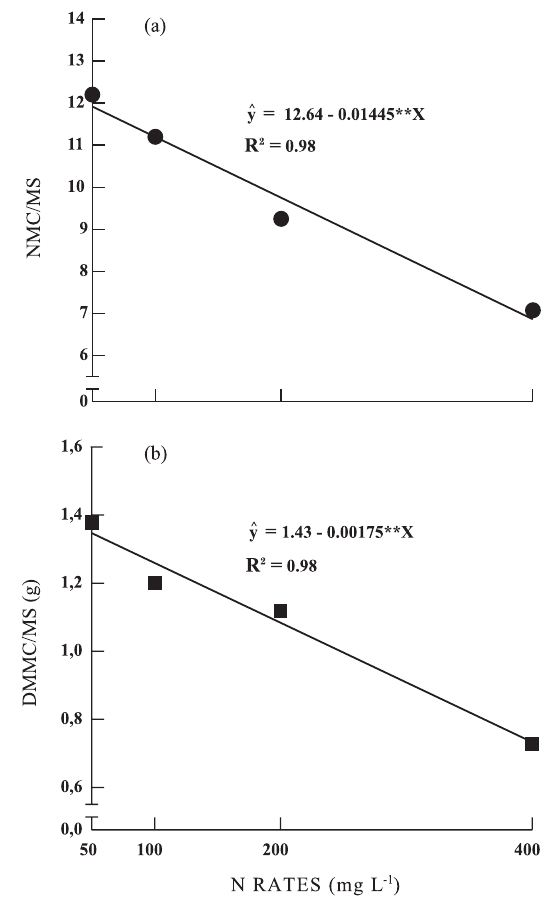
solutionFigure 1. Number of minicuttings per ministumps (NMC/MS) (a) and dry matter of minicuttings per ministumps (DMMC/MS) (b) of one single- cross Eucalyptus urophylla hybrid, as related to N rates in nutrient solution, during 30 days of collection. (** Significant at 1 % by the t